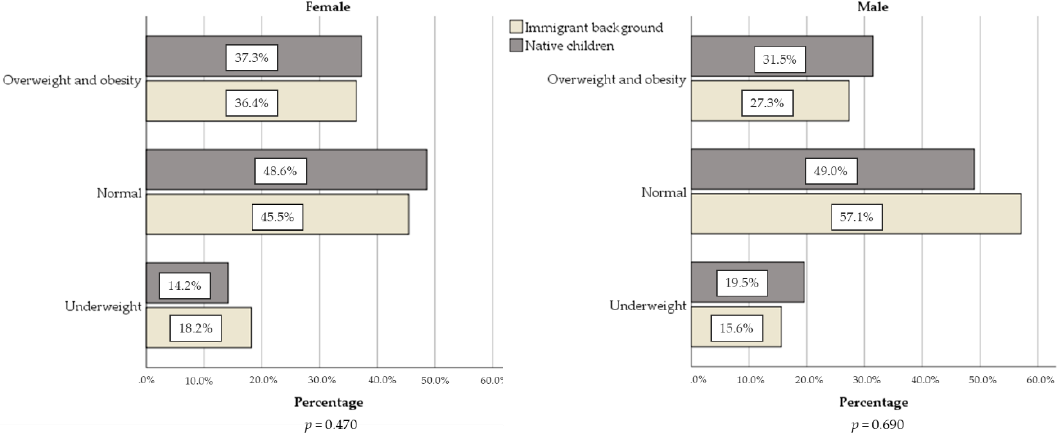
Figure 2. Nutritional status, according to CDC definition, for children with immigration background or native, separated by